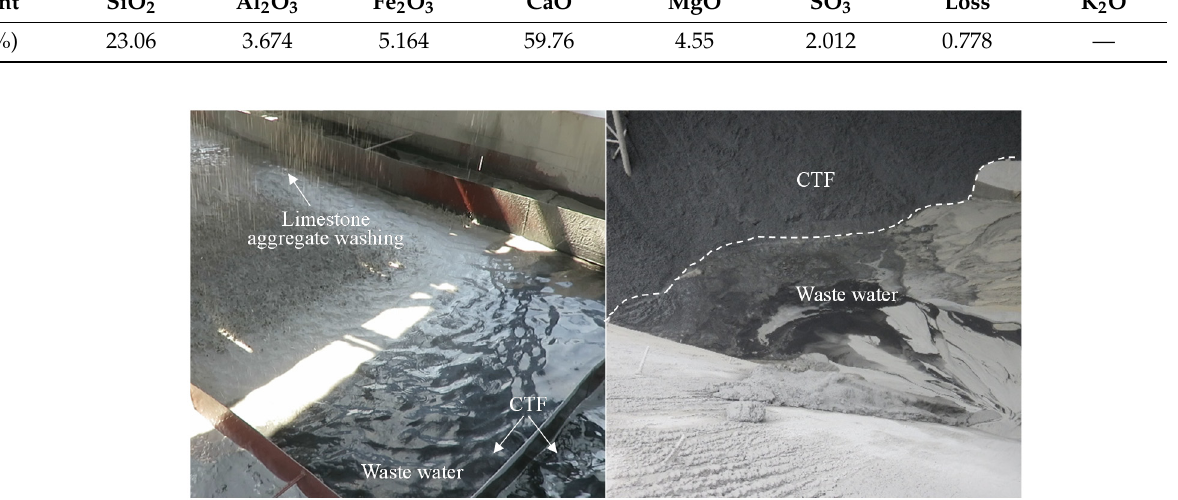
Table 3. The theoretical mixing amount of four-grade